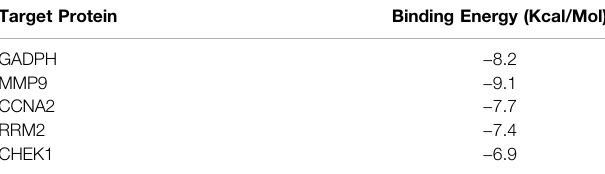
TABLE 2 | Binding energy of trastuzumab with core target genes.